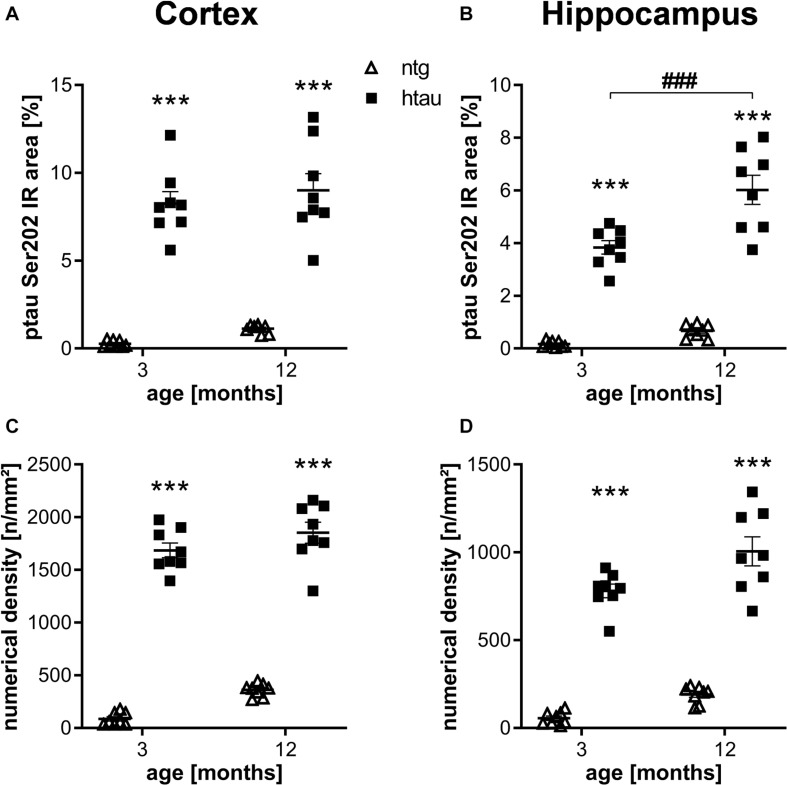
Quantification of ptau Ser202 levels in the cortex and hippocampus of 3 and 12 month old htau mice compared to non-transgenic (ntg) littermates by EPR2402 antibody. (A,B): Immunoreactive area in percent in the cortex (A) and hippocampus (B). (C,D): Object density in n/mm2 in the cortex (C) and hippocampus (D). n = 8 per group, 5 slides per animal. Mean + SEM; Two-way ANOVA with Bonferroni’s post hoc test; ***p < 0.001. *differences between genotypes; #differences between age groups.